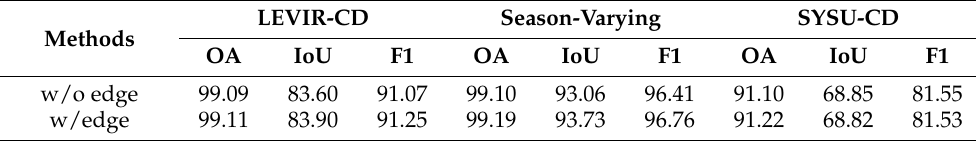
Table 6. Effects of edge-information feature-enhancement module.